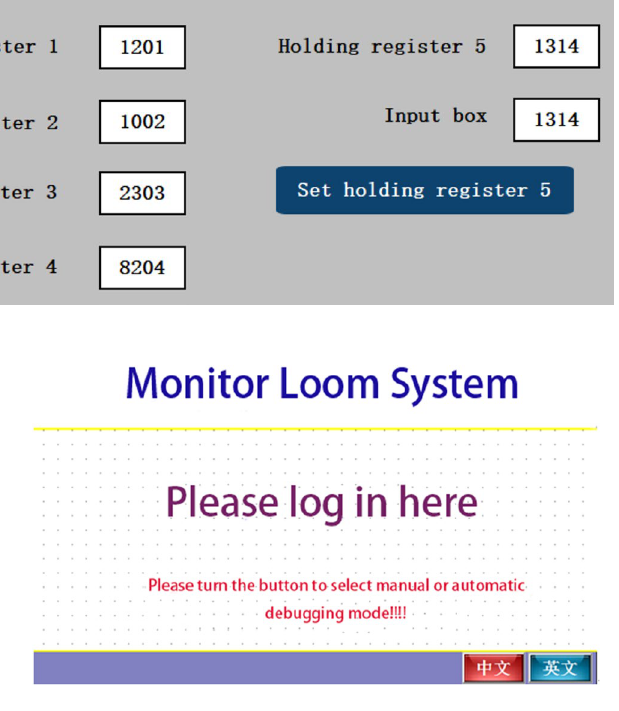
Fig. 16 STA connection list Fig. 17 Holding register read data and holding register write